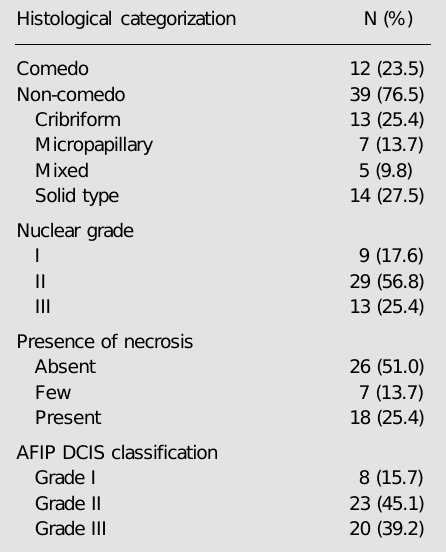
Table 1. Morphological features of the ductal car- cinoma in situ (DCIS) component in T1N0M0 breast